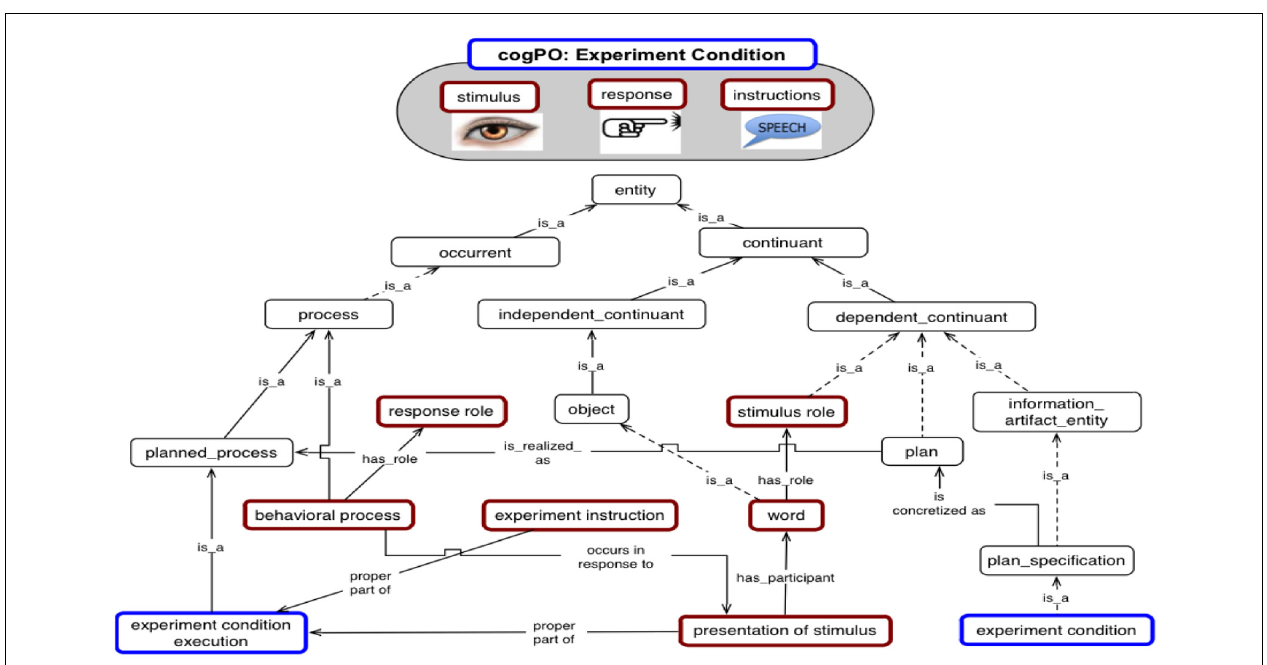
FIGURE 1 |A partial representation of the Cognitive Paradigm Ontology